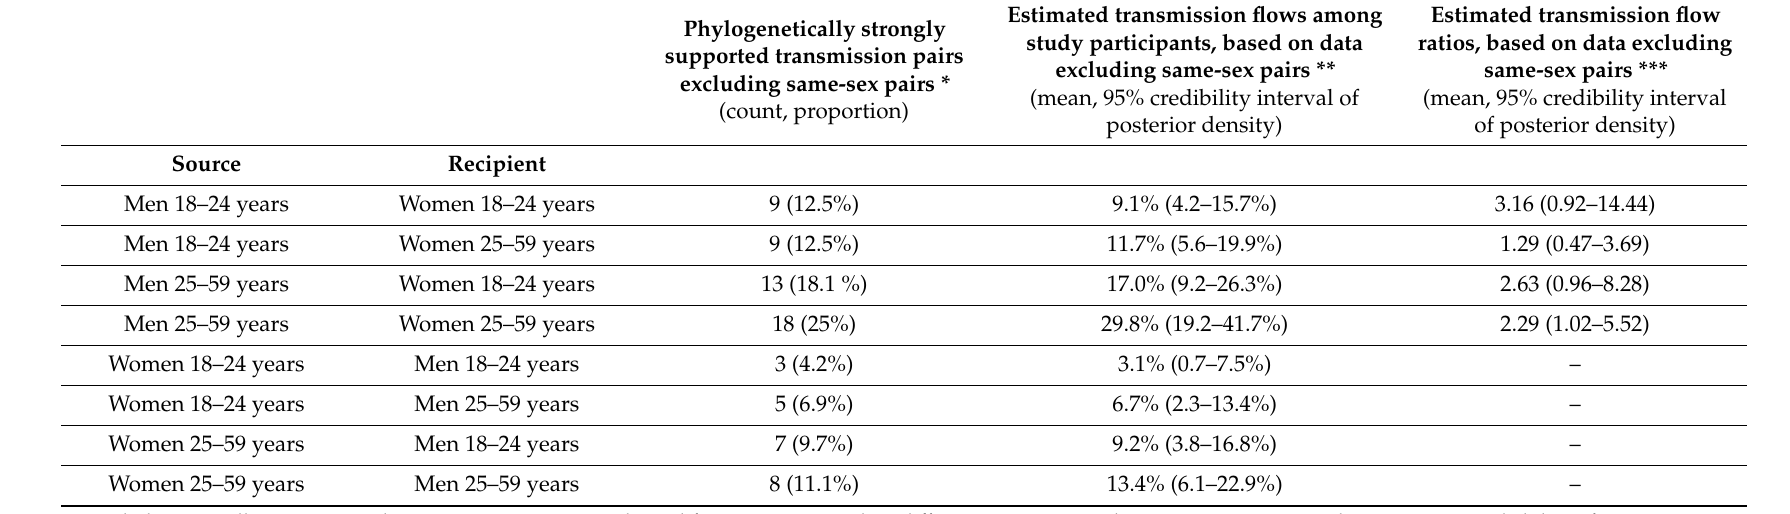
Table 4. Phylogenetically estimated transmission flows by age. Estimated transmission flows among Phylogenetically strongly study participants, based on data supported transmission pairs excluding same-sex pairs ** excluding same-sex pairs * (mean, 95% credibility interval of (count, proportion) posterior density)